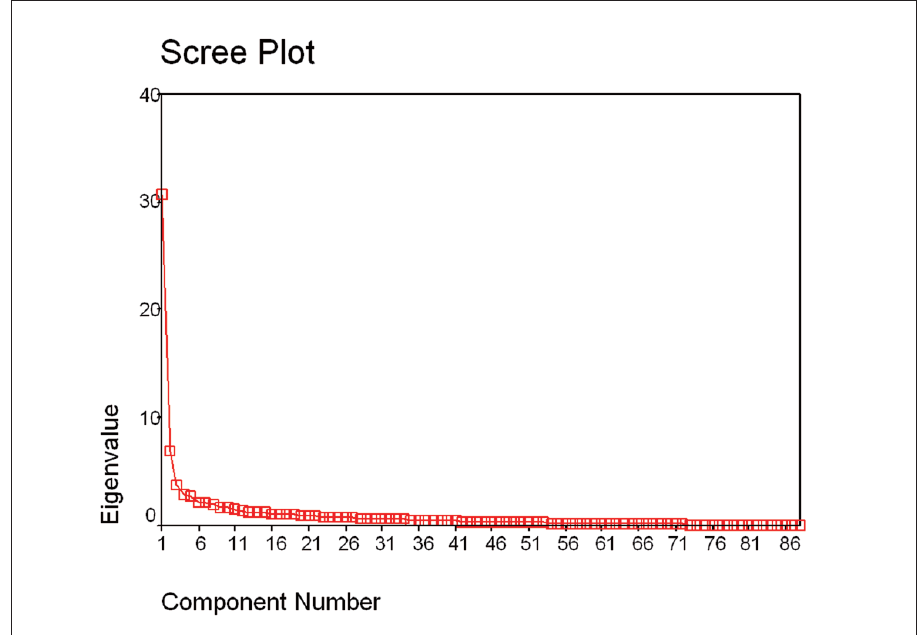
Picture 1 Eigen of the Factors on Website